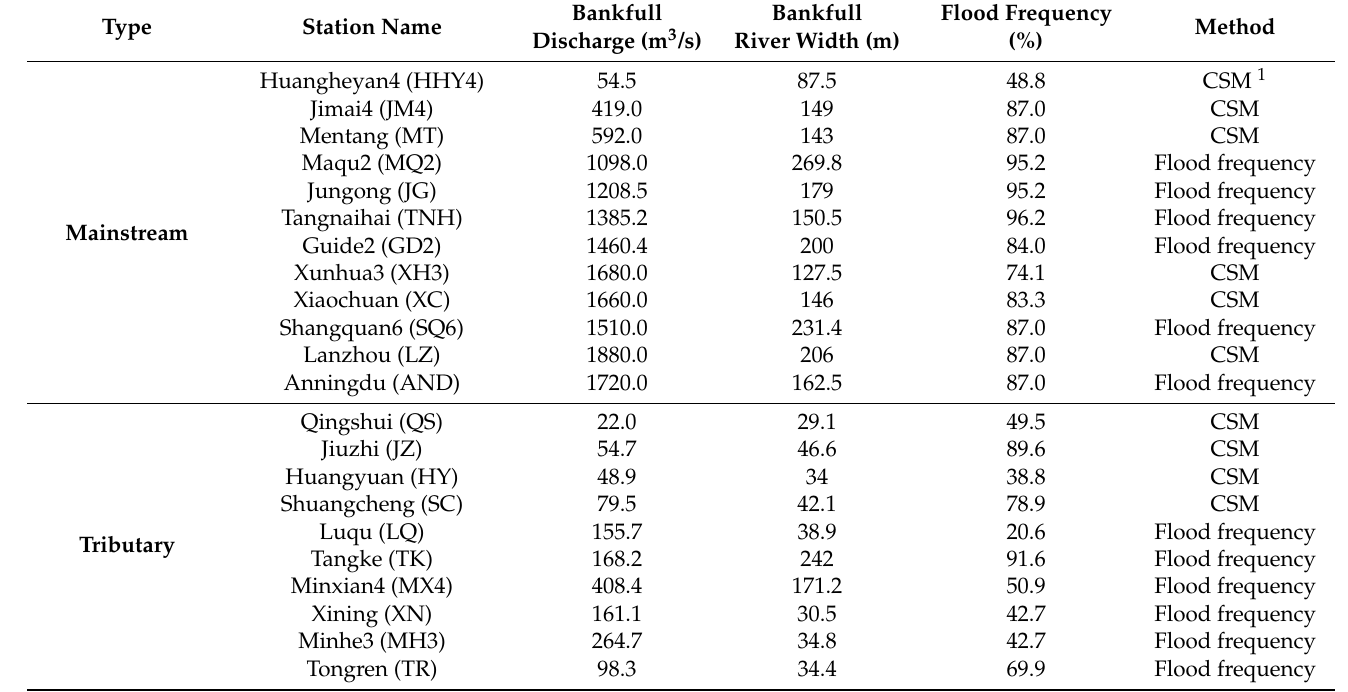
Table 2. Bankfull discharges, river widths, and flood frequencies of 22 hydrological stations.